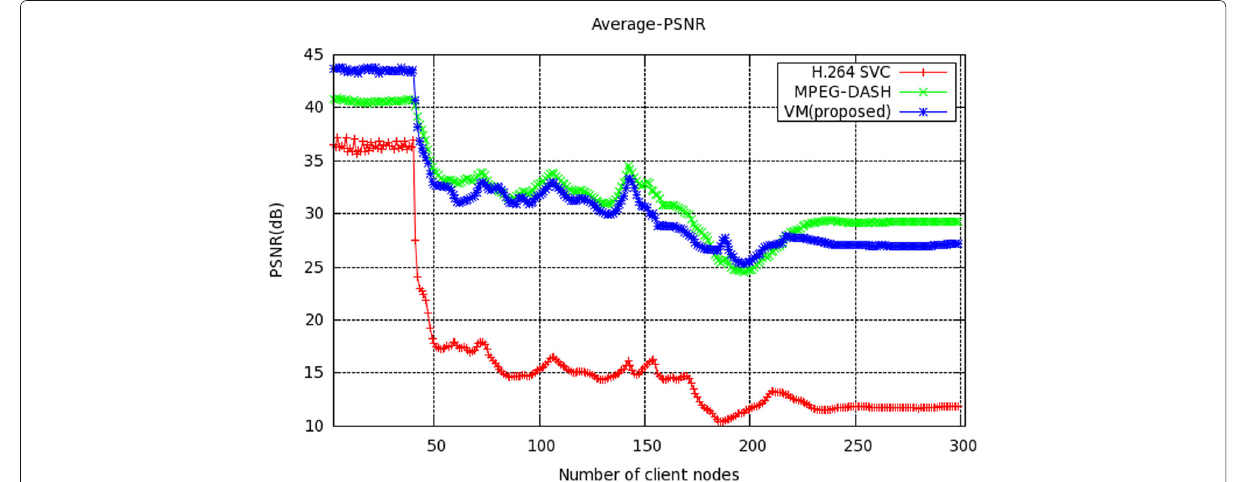
Fig. 4 Average PSNR of bit rate reduction techniques